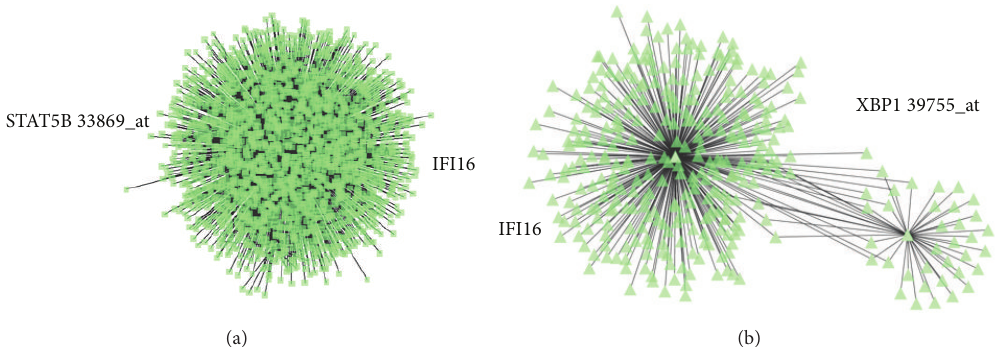
Figure 7: Relationship between IFI16 and select transcription factors as defined by ARACNe. Examples of direct interaction ((a) STAT5b- IFI16) and indirect interaction ((b) XBP1-IFI16) are plotted. In each panel, the green triangles represent molecules interacting with IFI16 (chosen as the centroid of the analysis).